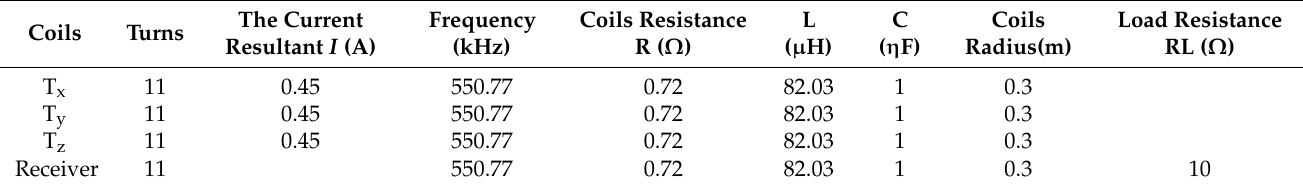
Table 1. 3D WPT System coils parameters.